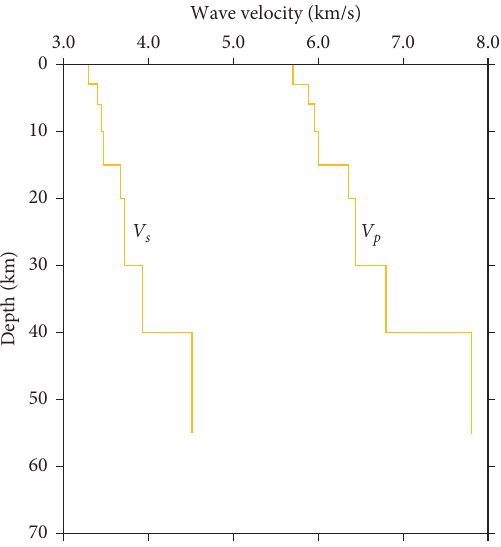
Figure 4: Crustal mean velocity model in the study area. Table 1: Crustal mean velocity model of P wave in the target